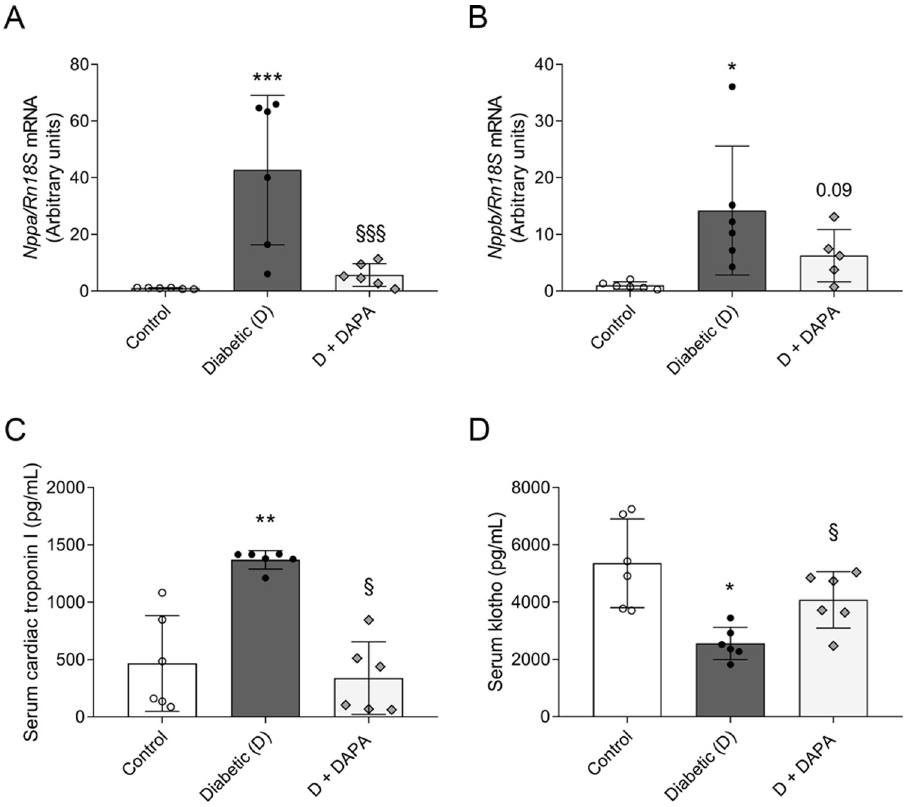
Fig 2. Diabetes-induced myocardial injury biomarker increment is halted by dapagliflozin. mRNA expression of (A) atrial natriuretic peptide ( Nppa ) and (B) B-type natriuretic peptide ( Nppb ) of control, diabetic and dapagliflozin treated diabetic rats (D+DAPA). mRNA expressions were normalized to Rn18S mRNA expression. (C) Serum levels of cardiac troponin I. (D) Serum levels of klotho. Bars indicate means ± SDs and data were analyzed by one-way ANOVA with Holm-Sidak multiple comparisons test or Kruskal-Wallis with Dunn comparison test (n = 6/group). � p < 0.05 vs . Control, �� p < 0.01 vs . Control, ��� p < 0.001 vs . Control, § p < 0.05 vs . Diabetic, §§§ p < 0.001 vs . Diabetic.